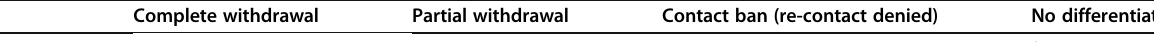
Table 4 Response to the question: “ What forms of withdrawal are used? ” Complete